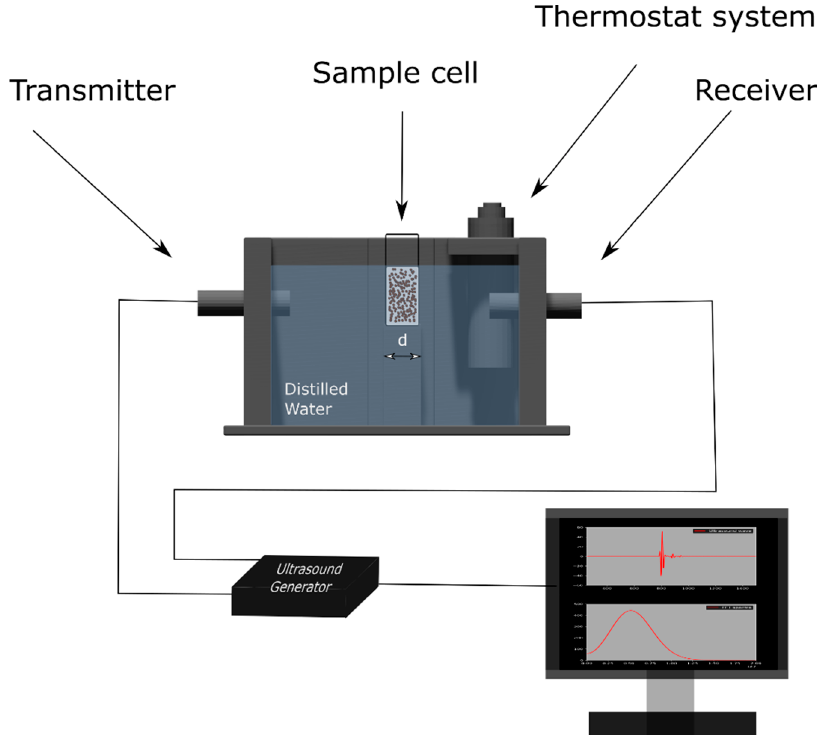
Figure 1. Scheme for an ultrasound measurement system consisting of an ultrasonic testing device with two piezoelectric broadband transducers (transmitter and receiver). Ultrasound wave propagated in the sample at a constant temperature of 25 °C.